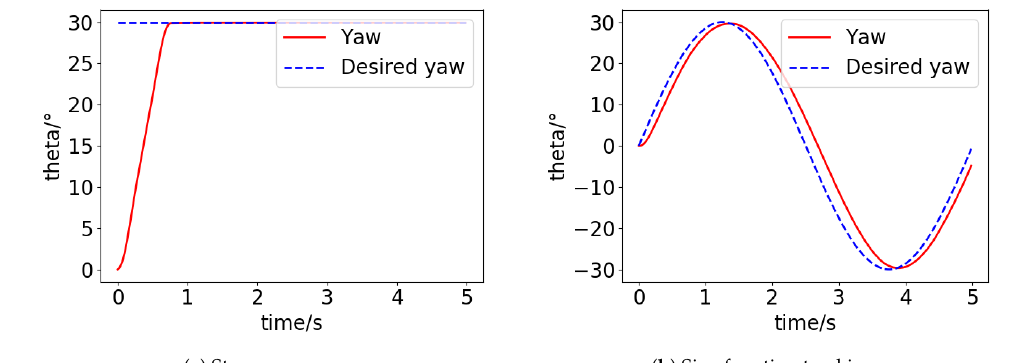
Figure 7. Performance along the yaw axis.